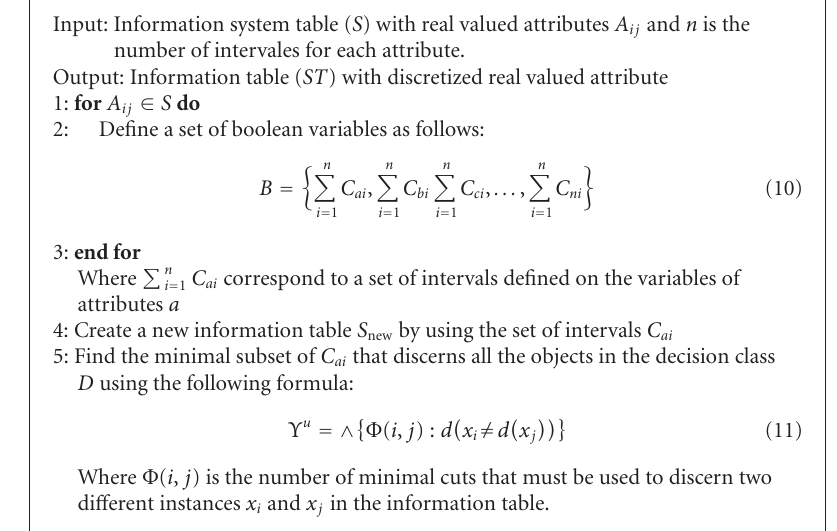
Algorithm 1: RSBR discretization algorithm.